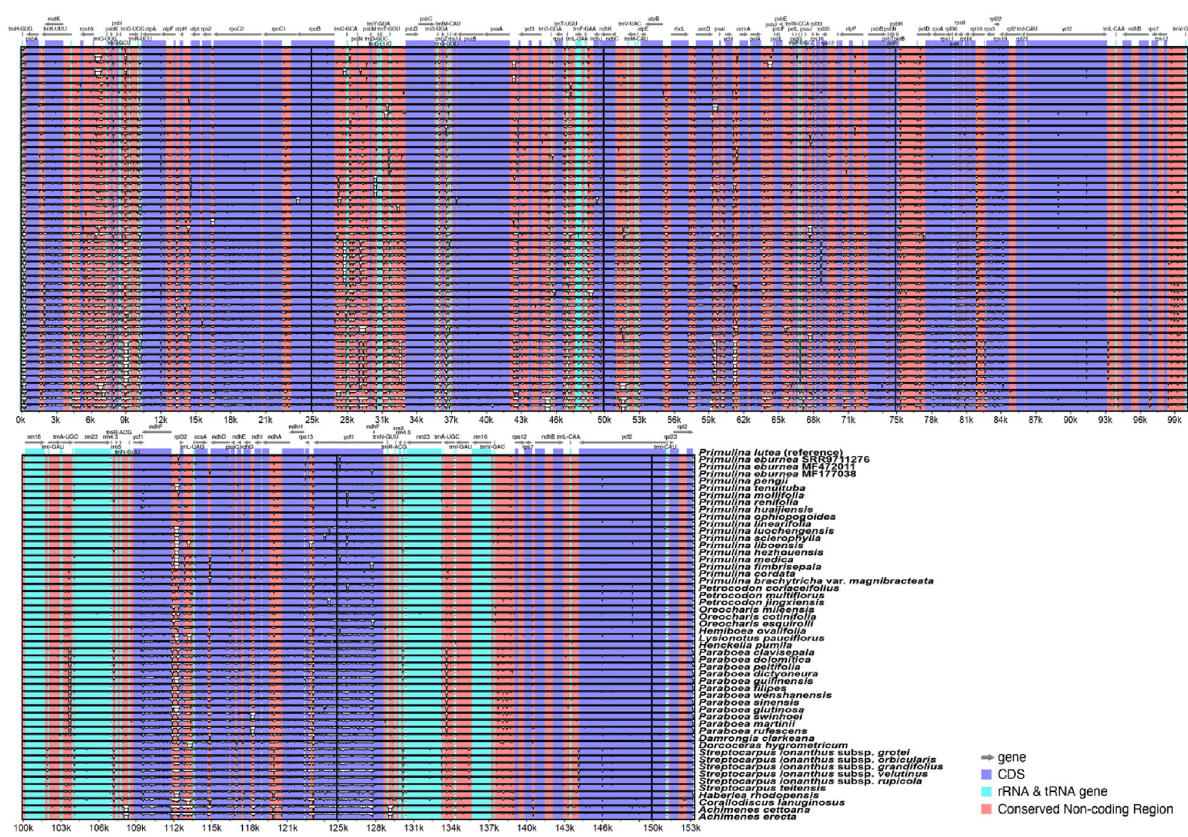
Figure 2. The plastome similarity comparison of Gesneriaceae plastomes using mVISTA. Primulina lutea was set as the reference. The filled boxes inside each row indicate the sequence similarities. Similarities lower than 50% are not shown. Purple boxes represent the protein-coding regions, cyan blue boxes represent the RNA genes, and red boxes are intergenic (non-coding)